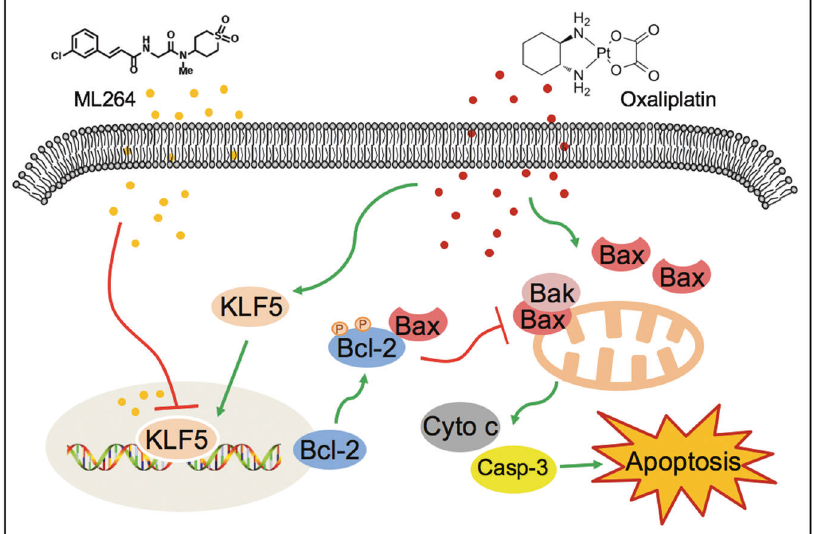
Fig. 7 Schematic diagram shows the mechanisms of how the CRC cells ’ resistance to oxaliplatin and ML264 restores oxaliplatin sensitivity of colorectal cancer. Overexpression of KLF5 and its downstream anti-apoptotic factor Bcl-2 was one of the mechanisms for CRC to resist